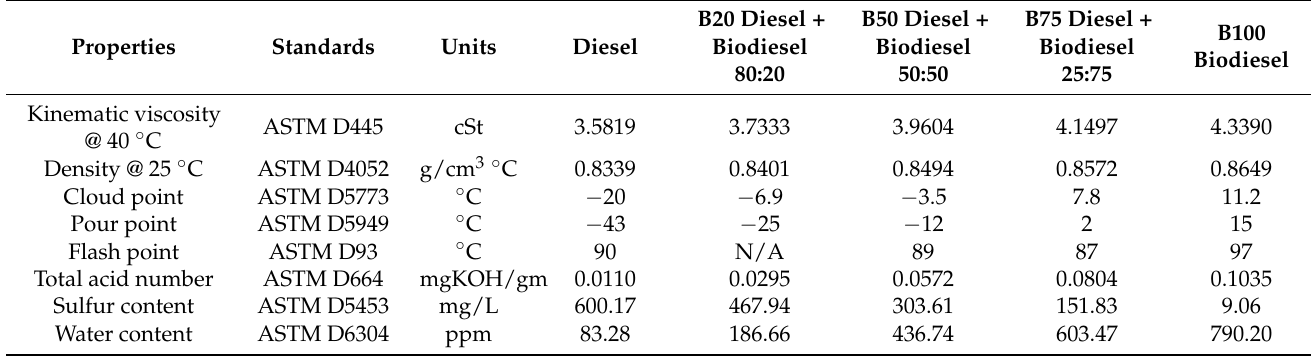
Table 3. Properties of the diesel and biodiesel